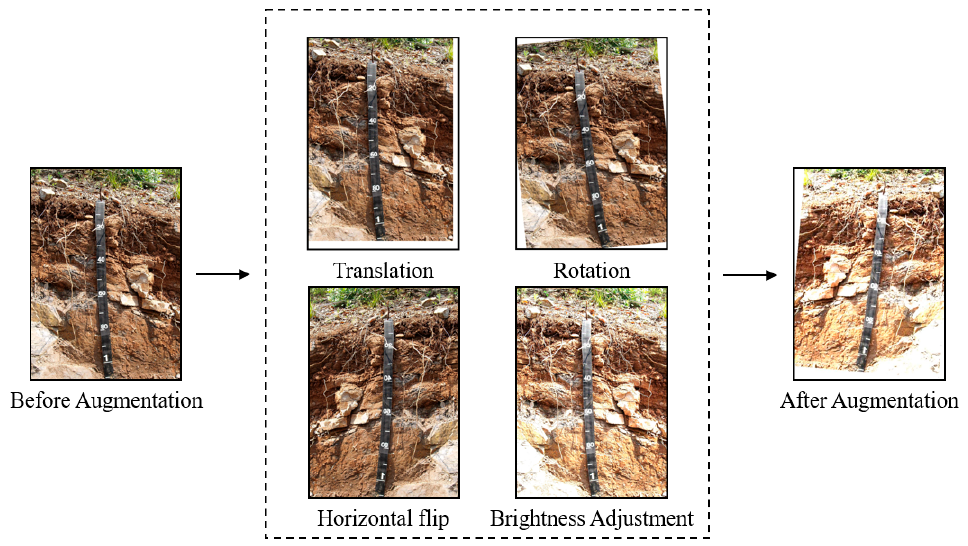
Figure 7. Soil profile images before and after augmentation.